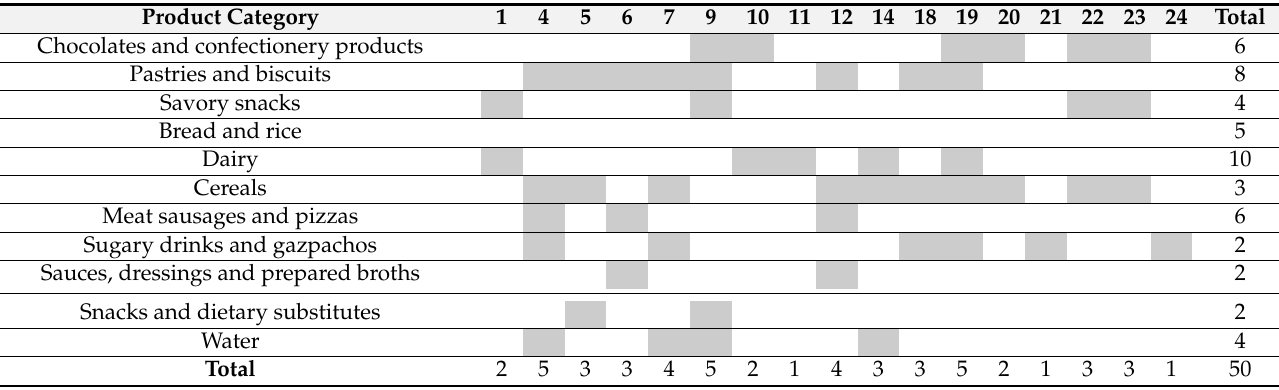
Table 3. Frequency of noncompliance ethical standards of the PAOS Code by product category. Product Category